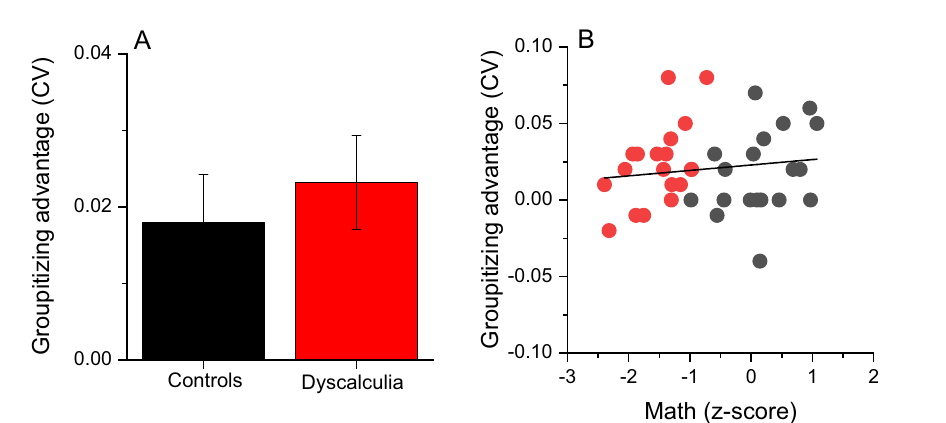
Figure 3. Groupitizing effect on estimation precision. ( A , B ) Average coefficient of variation as a function of numerosity for the two experimental conditions (empty circles: randomly spaced stimuli, filled circles: grouped stimuli). ( C ) Coefficients of variation averaged across numerosity levels and participants. Error bars show ± 1 SEM.